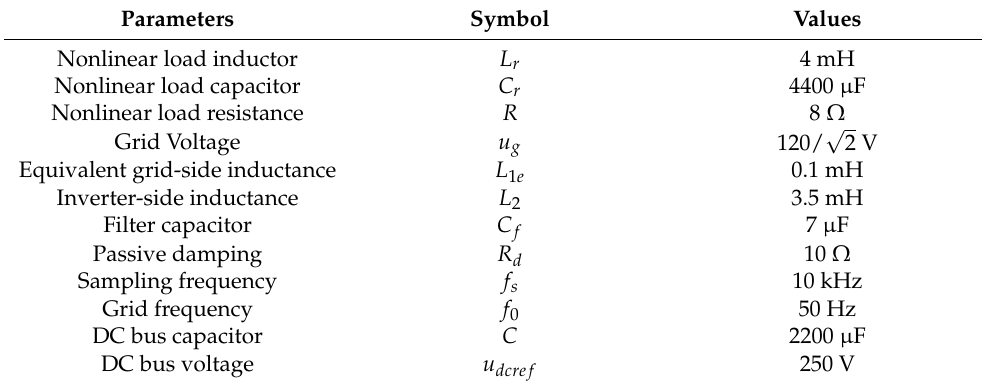
Table 1. APF simulation model parameters.